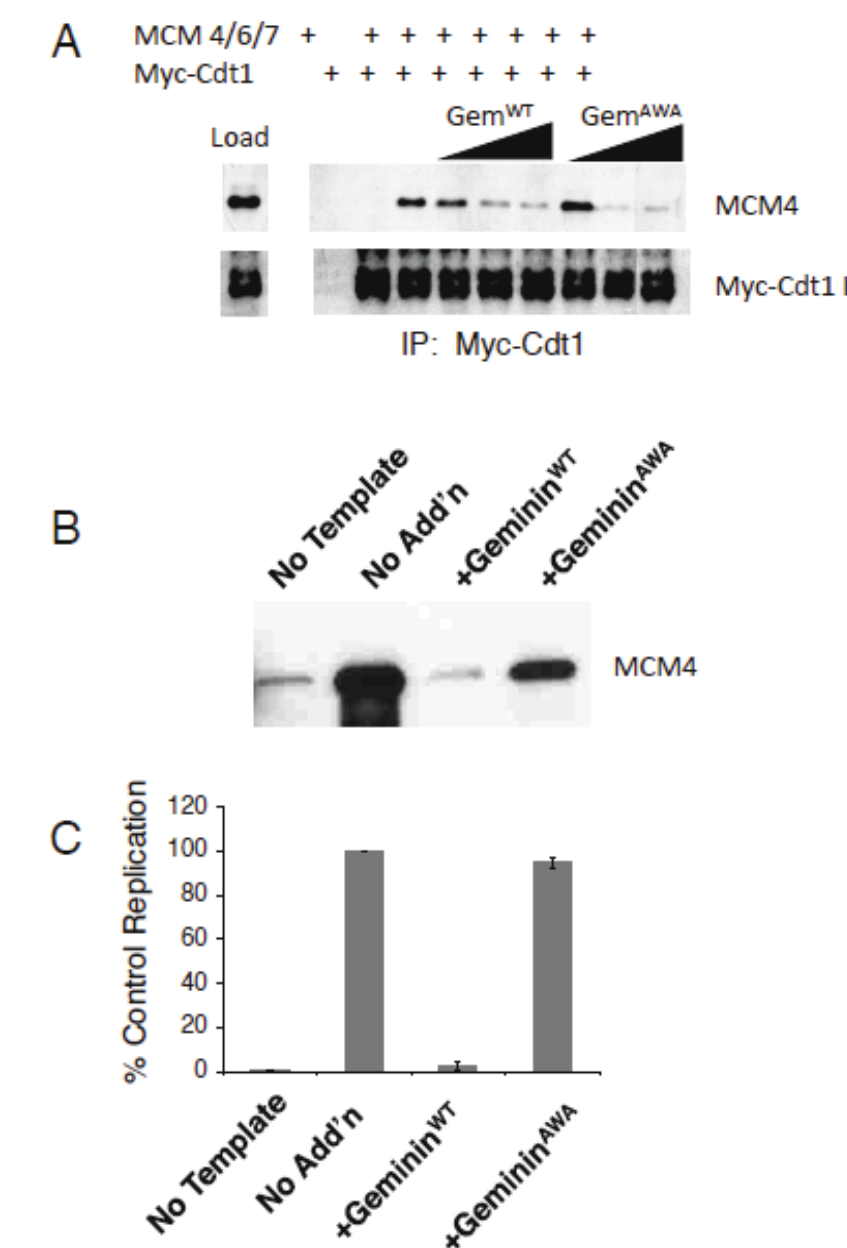
Figure 3. Geminin AWA inhibits MCM loading in vitro but not in vivo . ( A ) Geminin AWA inhibits the MCM (cid:2)(cid:3) Cdt1 interaction in vitro . Increasing concentrations of recombinant Geminin protein (5 µg/mL, 10 µg/mL, or 40 µg/mL) were mixed with translated